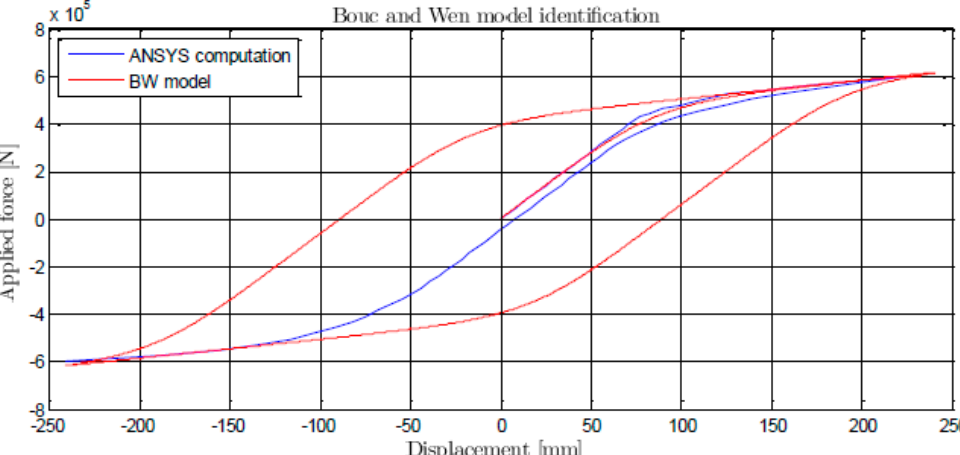
Figure 6: Comparison of the identified BW model with the ANSYS results (signum function approximated with s